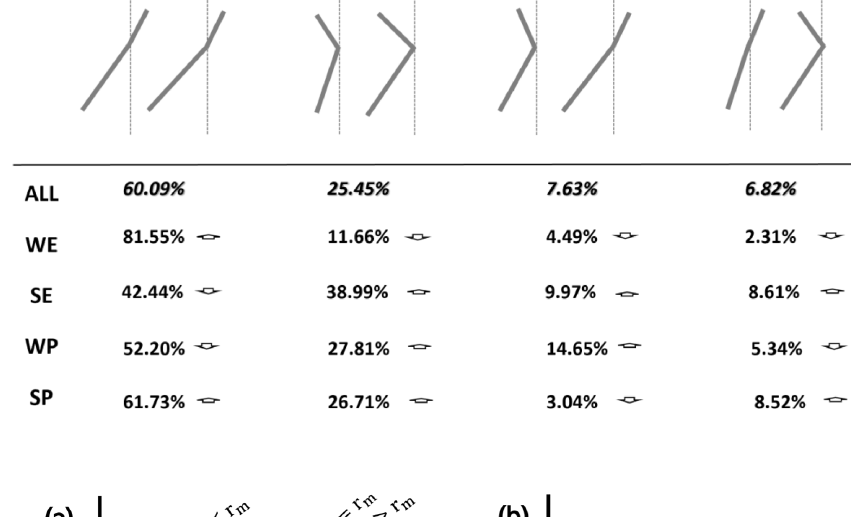
Table 2. The main four LWC–ER patterns that appeared in our analyses and their percentage in terms of the following scenarios: ALL, all cloud profiles; WE, cloud profiles associated with weak cloud-top entrainment; SE, cloud profiles with strong cloud-top entrainment; WP, cloud profiles with weak precipitation; SP, cloud profiles with strong precipitation. The green and red arrows beside the numbers indicate the increase or decrease in the percentage compared with the reference statistics using all samples.